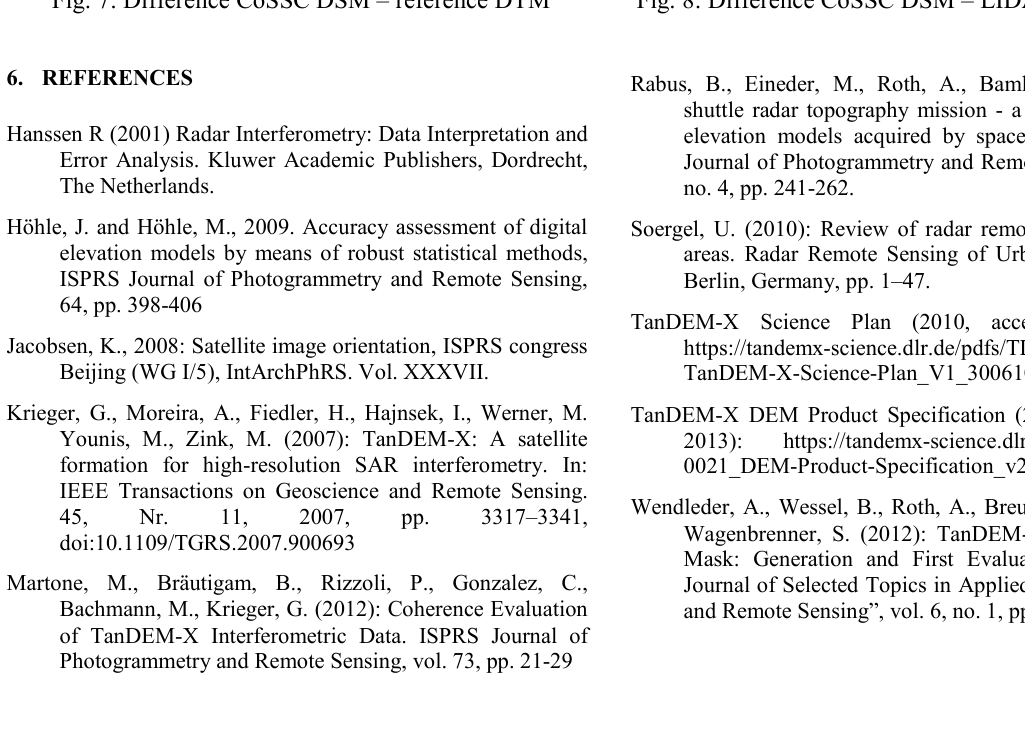
Fig. 7: Difference CoSSC DSM – reference DTM Fig. 8: Difference CoSSC DSM – LIDAR